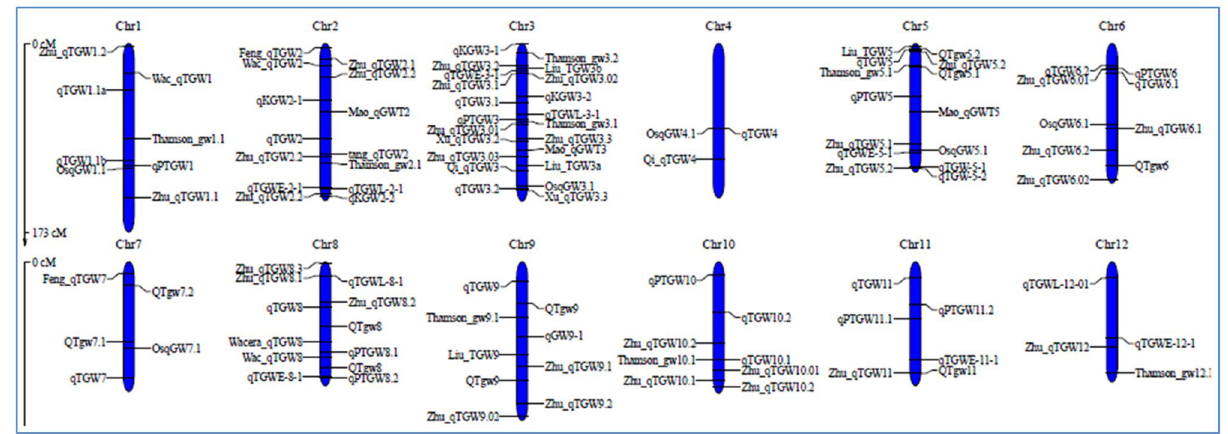
Figure 2. Distribution of reported grain weight QTL on all 12 rice chromosomes (name of the first author of original report is used as prefix while naming the QTL in this